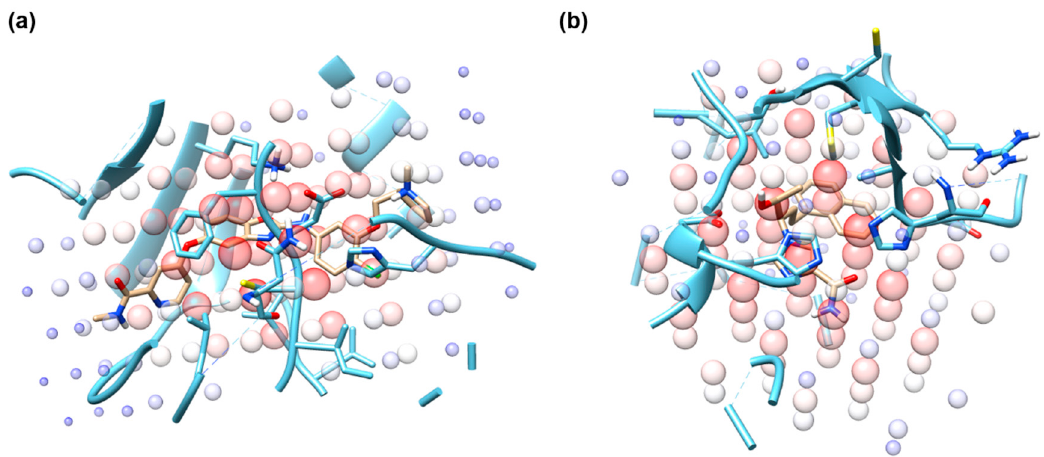
Figure 6. Grad-CAM analysis examples of protein-ligand complexes whose PDB IDs are ( a ) 2QU6 and ( b ) 2E1W. The size and color of transparent spheres indicate the magnitude of the sum of gradients. Receptor and ligand are colored in blue and gold, respectively.